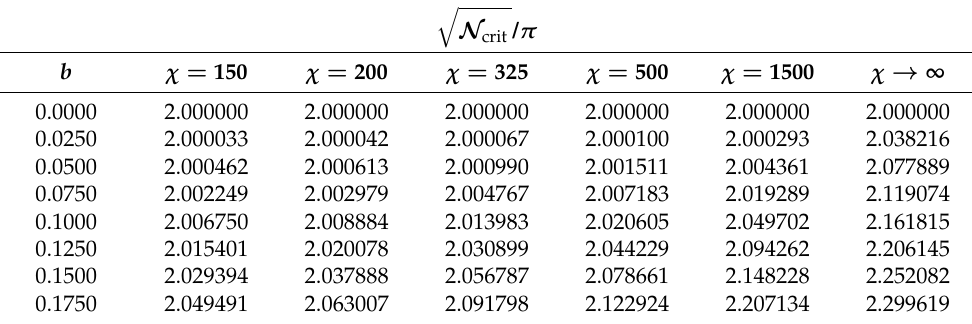
Table 3. The critical forces of FssF beams if χ = 150, . . . ,1500 and χ → ∞